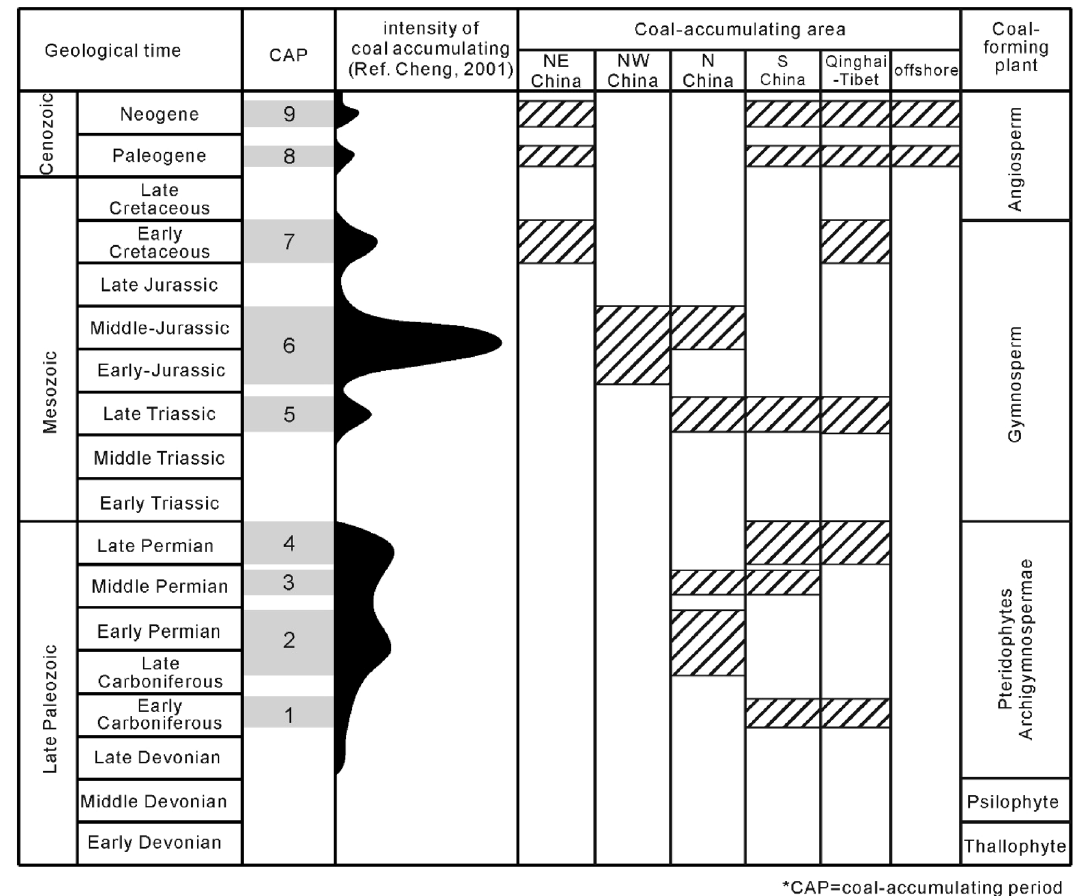
Fig. 3 The main coal-accumulating periods in China (revised after Han and Yang 1980; Zhang 1995; Cheng 2001; Qin